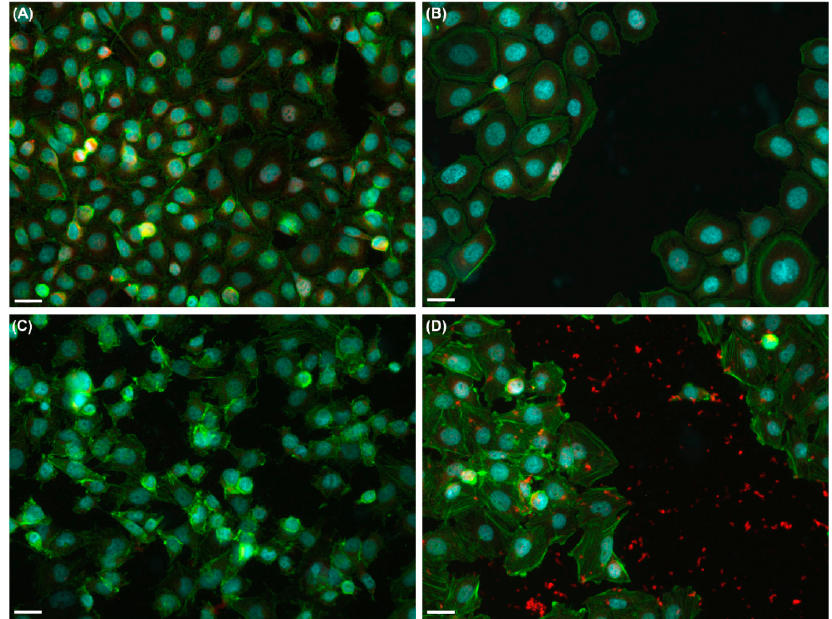
Figure 7. Effects of 60 min UVA exposure on the focal contacts of keratinocytes as revealed by anti-FAK immunofluorescence (in red). ( A , B )—HaCaT; ( C , D )—DOK. Note that UVA exposure had very few effects on normal keratinocytes (compare ( A ), for mock-irradiated cells, with ( B ) for exposed cells followed by scratching), while UVA radiation increased the strength of focal contacts in DOK cells resulting in many focal contacts extracted from the cells remaining attached to the culture surface in the scratched area. Nuclei are marked in blue with DAPI; actin filaments are in green. Scale bars represent 50 µm.